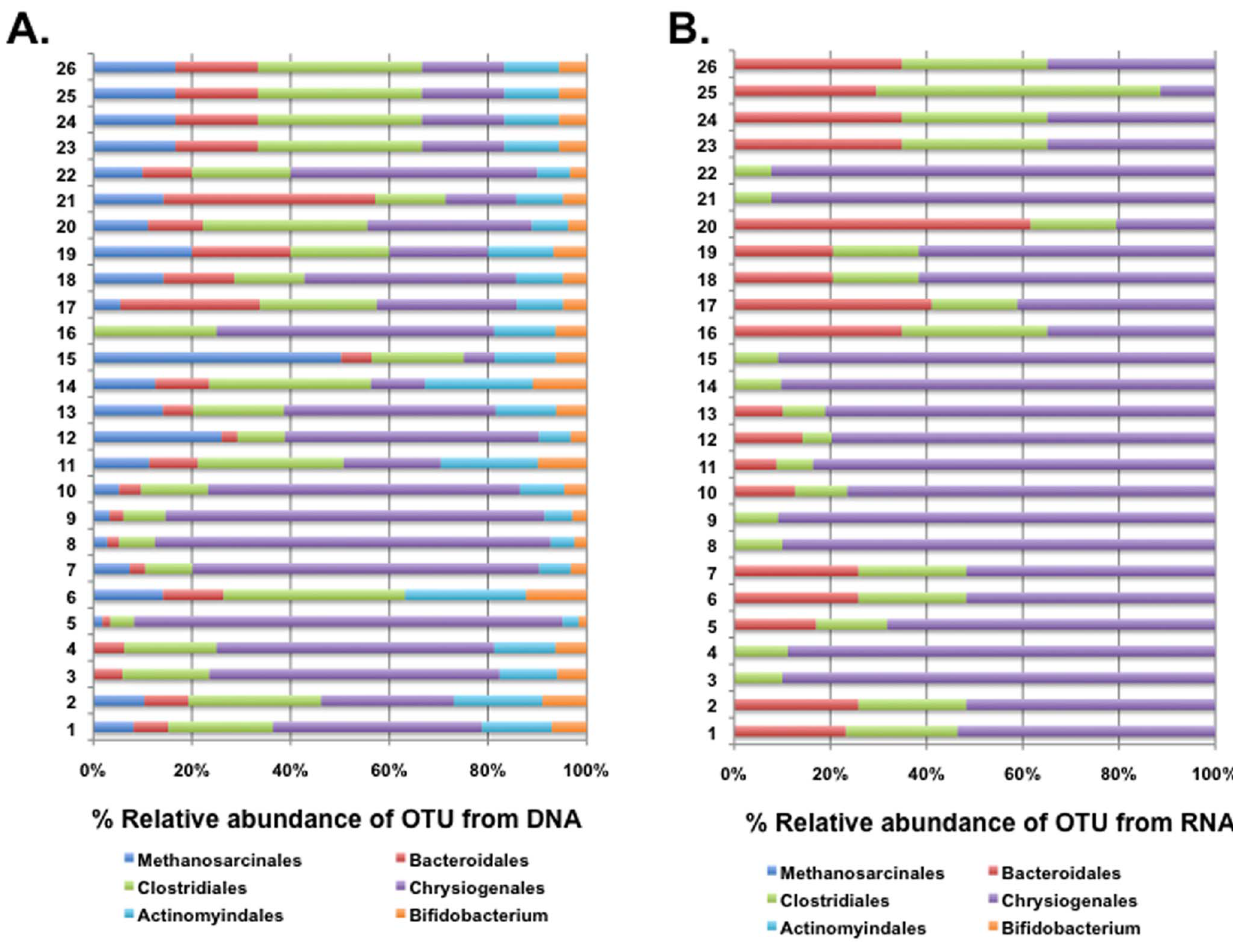
Figure 2. Identification of anaerobic bacterial populations among sputum samples from CF patients presenting with exacerbation. Percentage sequences from DNA-based (A) and RNA-based (B) approaches are described. The coloured segments of each bar represent the proportion of reads mapping to different anaerobic bacterial orders.